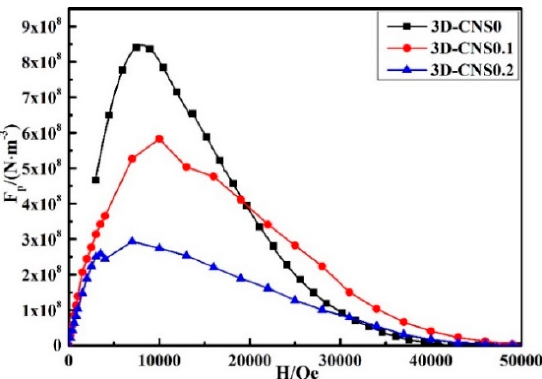
Figure 9. Flux pinning force curves of undoped and 3D-CNS doped samples.